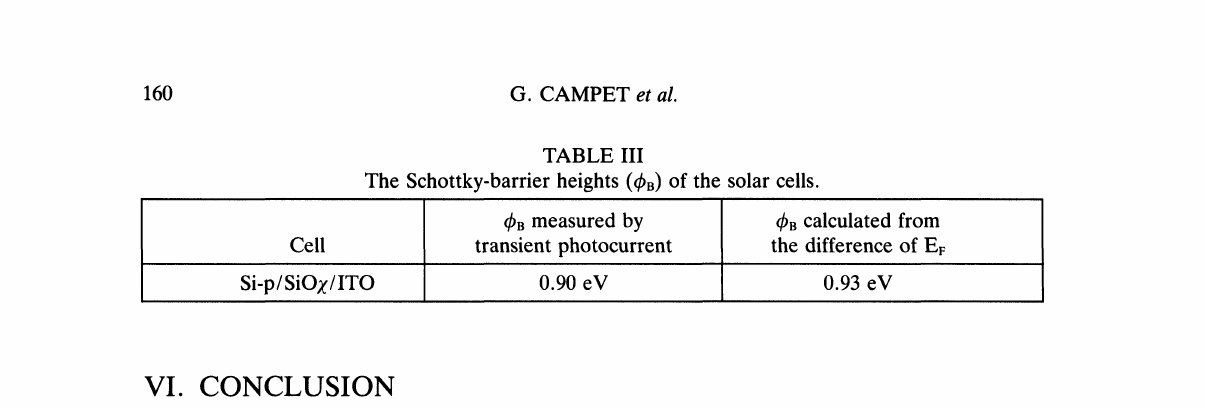
The Schottky-barrier heights (a) of the solar cells.